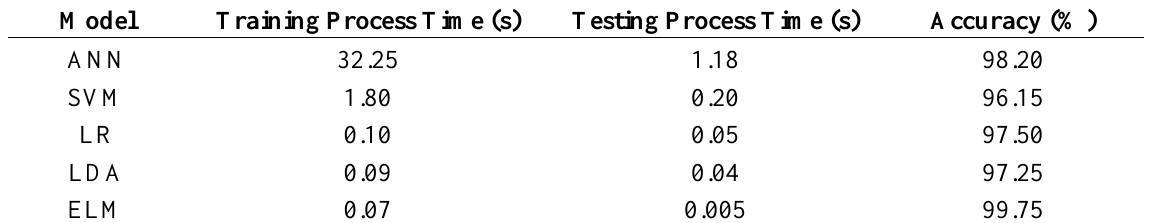
Table 8. Performances of the ANN, SVM, LR, LDA and ELM learning machines [112].